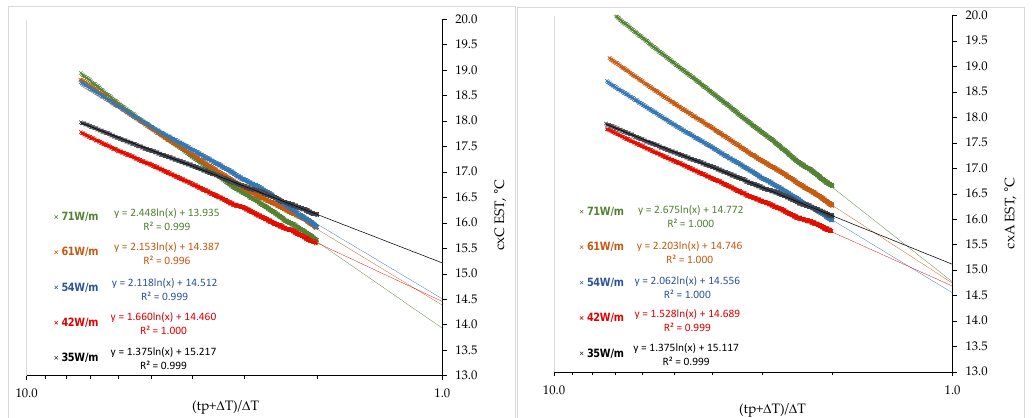
Figure 8. Horner’s semi-log method for determining ground thermal conductivity applied to a TRT recovery period for each heat power step and flow regime.